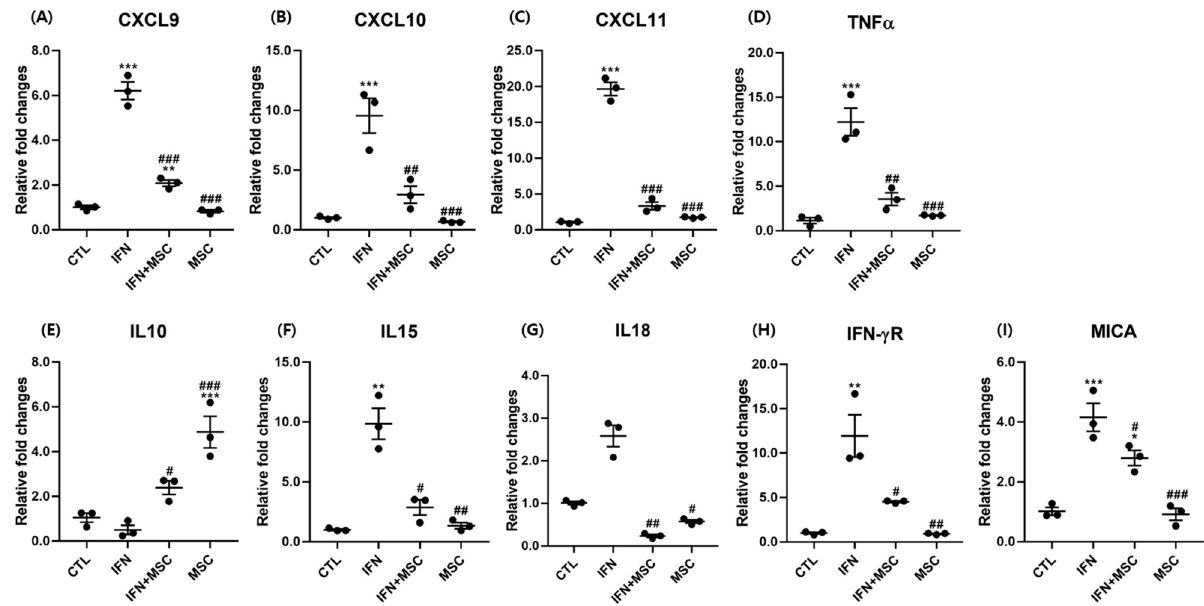
Figure 3. Analysis of gene expression by RT-PCR. The mRNA expression of ( A ) CXCL9, ( B ) CXCL10, ( C ) CXCL11, ( D )TNF- α , ( E ) IL-10, ( F ) IL-15, ( G ) IL-18, ( H ) IFN- γ R, and ( I ) MICA in hORSCs. HF-IP collapse-related genes were upregulated by IFN- γ and reverted by MSCT. Error bars represent the mean ± SEM, n = 3. Statistically significant at * p < 0.05, ** p < 0.01, and *** p < 0.001 compared to the control and # p < 0.05, ## p < 0.01, and ### p < 0.001 compared to the IFN- γ -treated group.